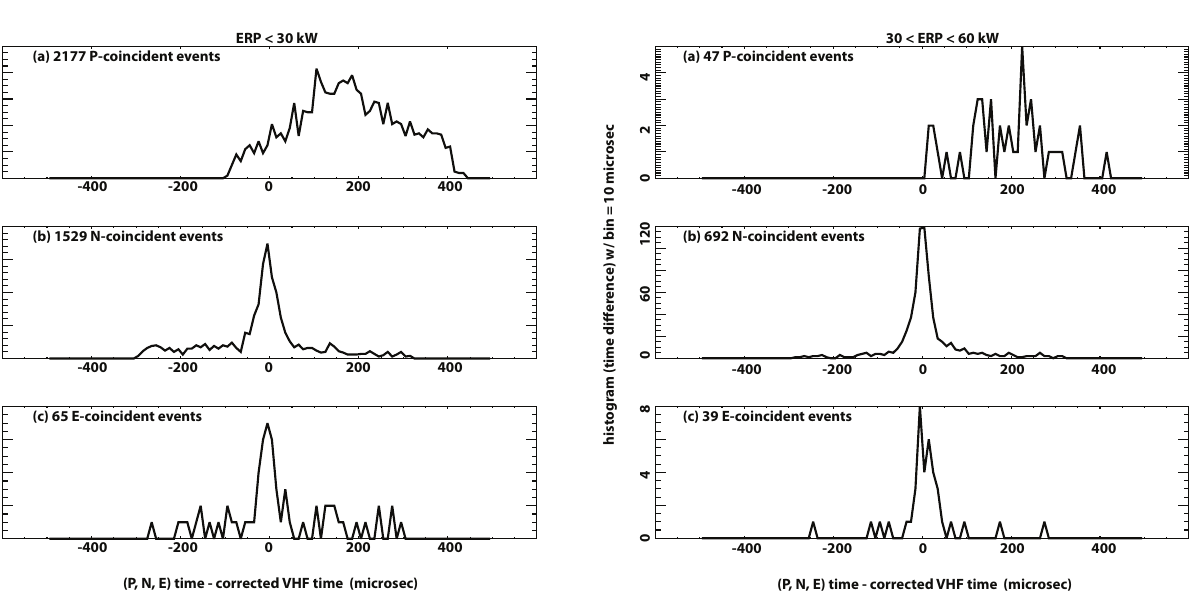
Fig. 9. Similar to Fig. 8, but for VHF events of mid-range power: 30 < ERP <